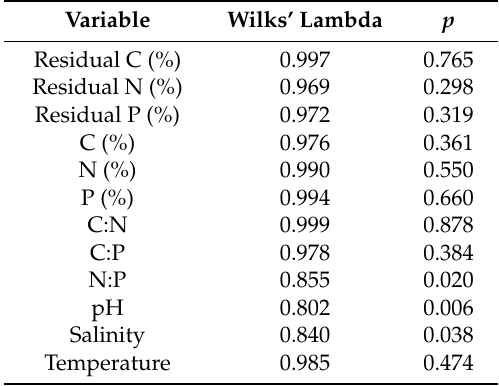
Table A4. Statistical significance of the independent variables in the general discriminant analysis with the habitat (ridge or ditch) of rice straw decomposition as the dependent categorical variable. Bold type indicate significant differences ( p < 0.05).